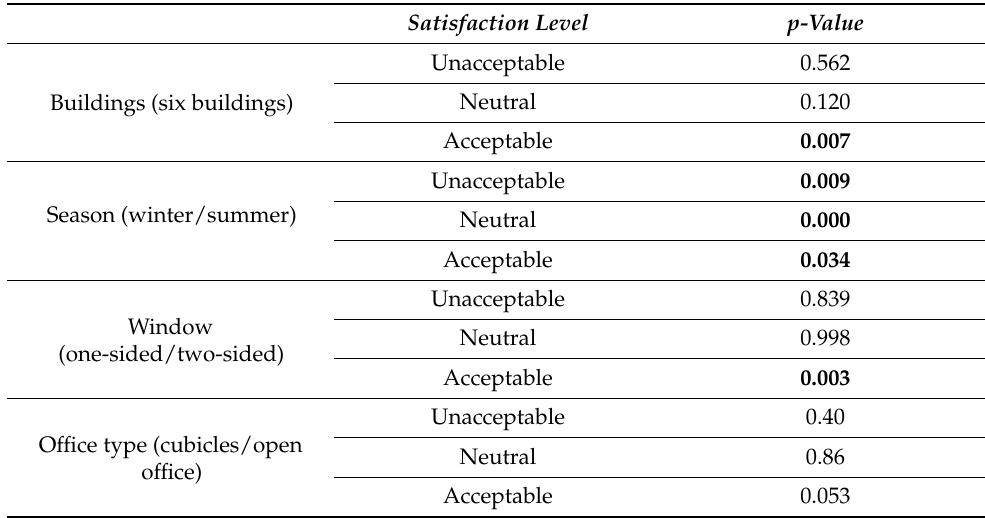
Table 4. One-way ANOVA and t-test results of variables and DTR